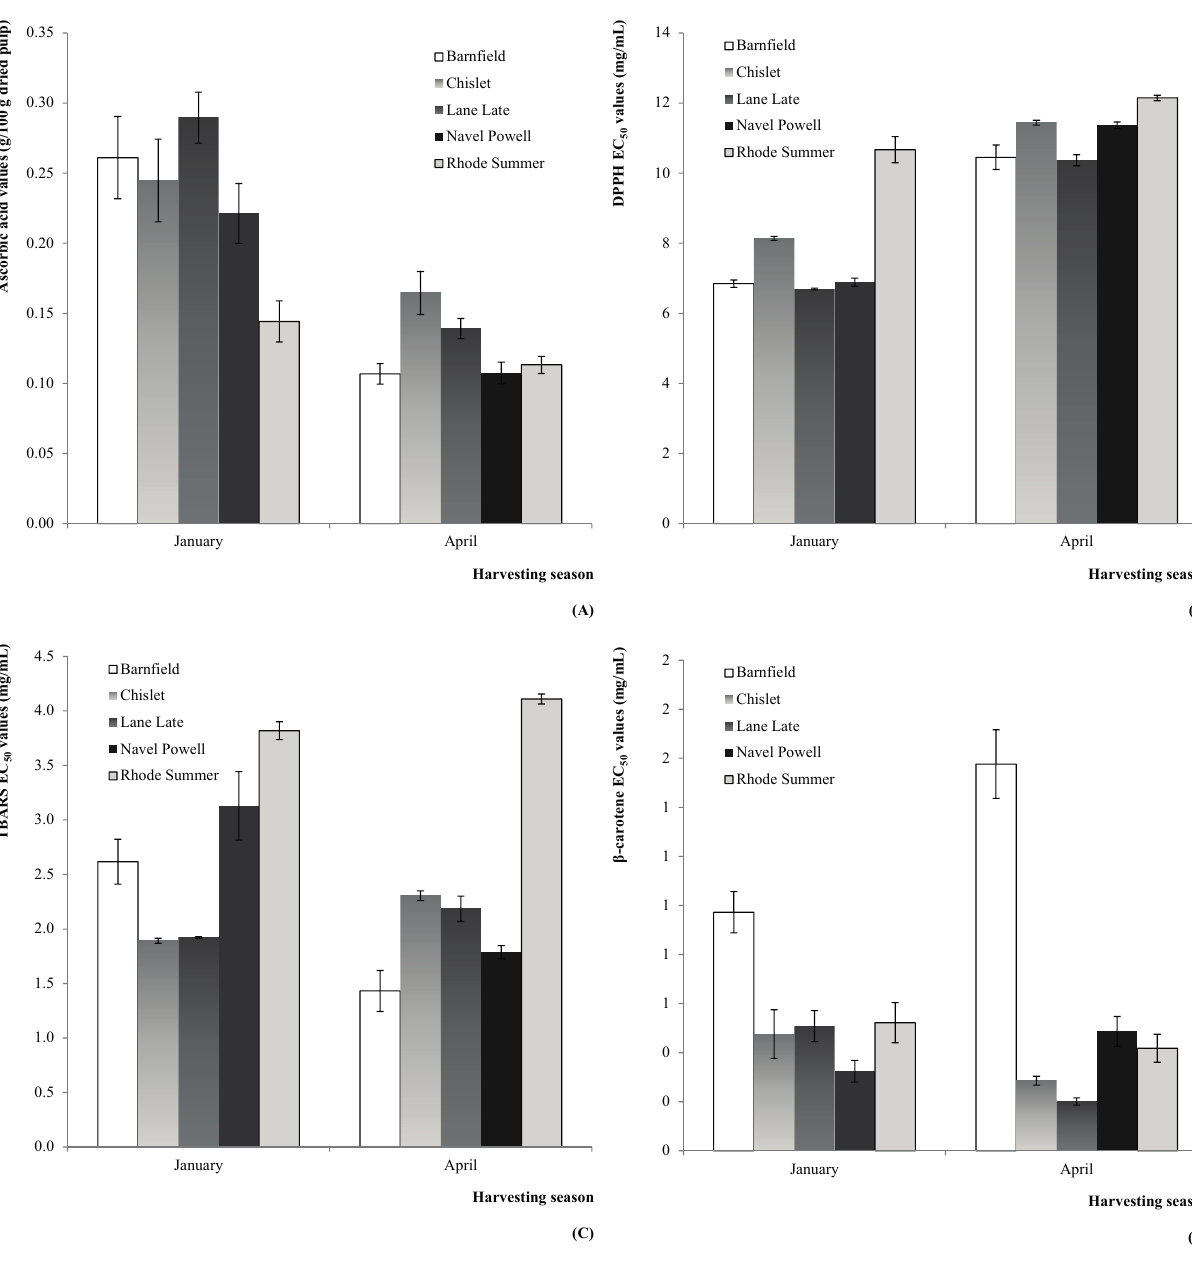
Figure 4. Estimated marginal mean plots representing the effect of OV on the antioxidant parameters of C. sinensis fruits: ( A ) ascorbic acid (2012); ( B ) DPPH scavenging activity (2011); ( C ) TBARS formation inhibition (2011); and ( D ) β -carotene bleaching inhibition